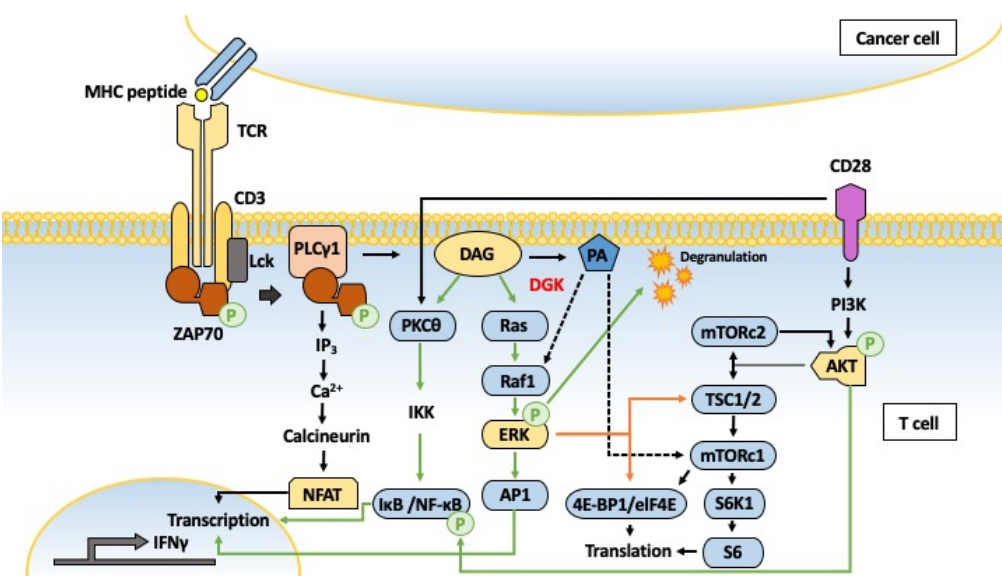
Figure 4. Representative signaling pathways regulated by diacylglycerol kinases (DGKs) in the activated T cells. Our understanding about diacylglycerol (DAG)-mediated regulation of Ras-MEK-ERK and PKC-NF- κ B is majorly based on T cell biology. Immunological synapse formation between T cell and cancer cell is shown as a representative model here. Signals originating from T cell receptor (TCR) engagement of peptide/MHC complex in the presence of co-stimulatory signal lead to the recruitment of adaptor molecules and degranulation, which promote the lysis of the target cells and secretion of IFN γ (T cell effector function). DGKs downregulate the levels of DAG, which activates the TCR distal signaling through Ras-ERK and NF- κ B (green arrow). The biosynthesis of phosphatidic acid (PA) in the T cells is mediated by DGKs and phospholipase D (PLD) (not shown). PA is shown to activate Raf1 and mTORC1 in the immune and non-immune cells (dotted black arrow).